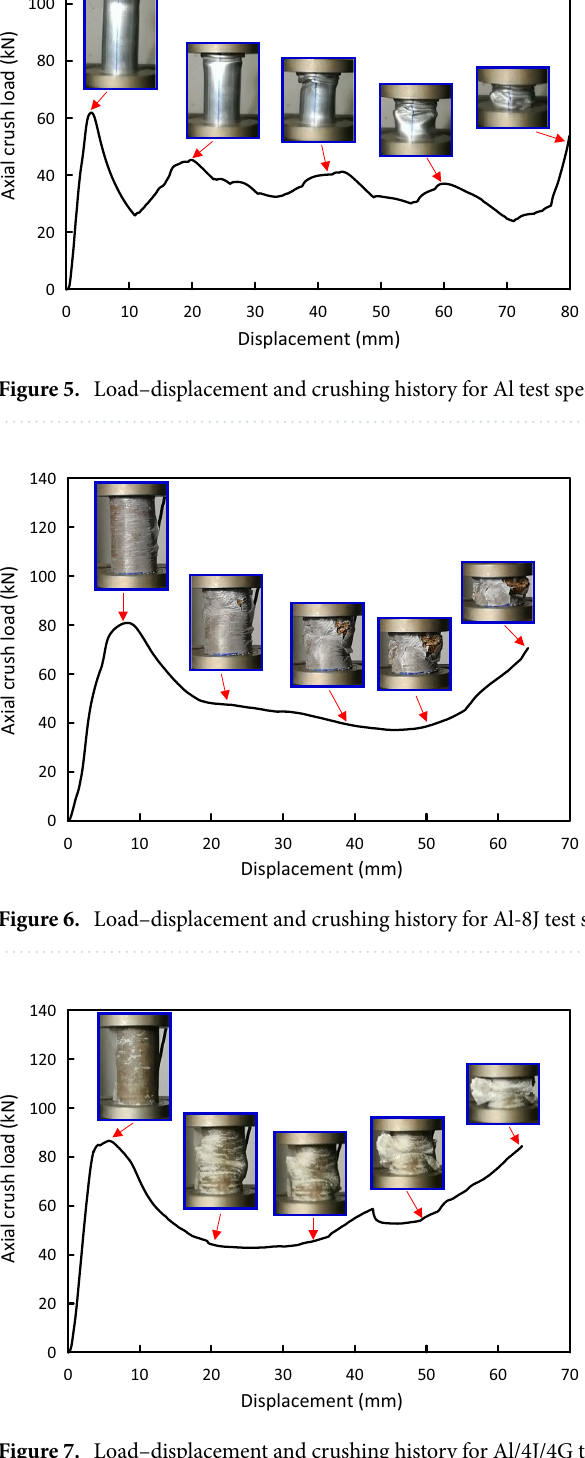
Figure 7. Load–displacement and crushing history for Al/4J/4G test